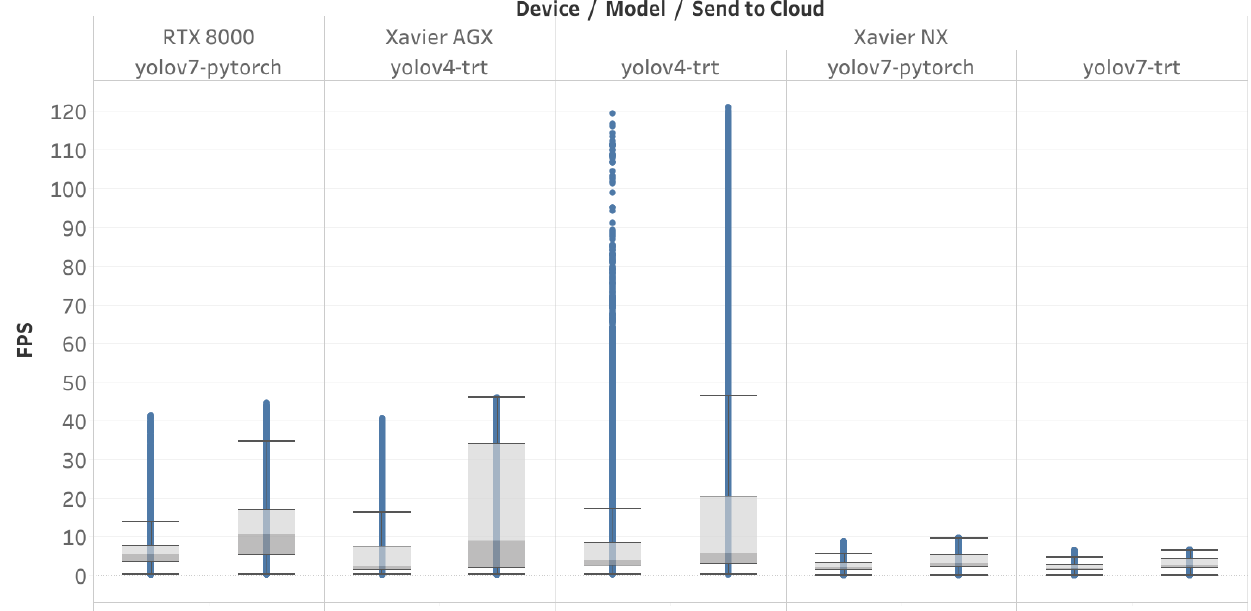
Figure 8. Inference speed per device, detection model, and connection to the